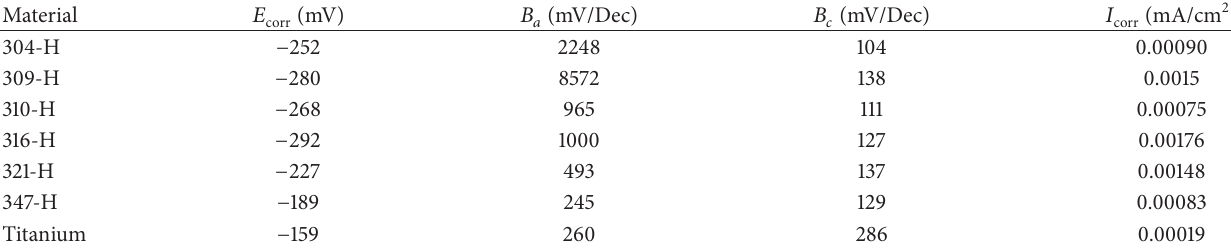
Table 3: Electrochemical parameters of materials in artificial saliva at 37 ∘ C.